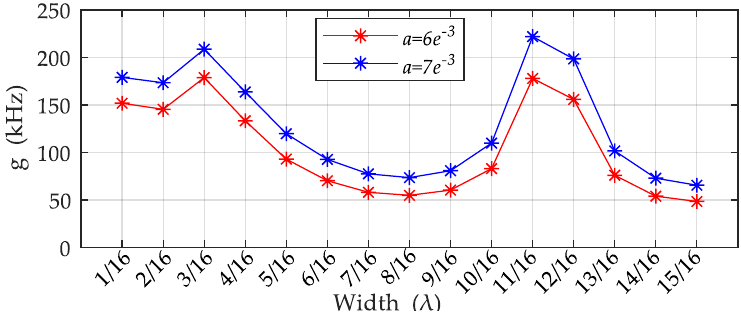
Figure 9. The influence of a value from − to 10 on the SAW gyroscopic effect.